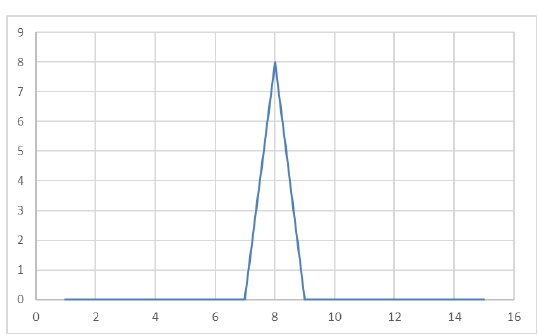
Fig. 10. NACF for a binary sequence of an even length of N = 8 with a section length of i = 2, | R bmax | = 0 for any shift (0°, 90°, 180°, 270°).